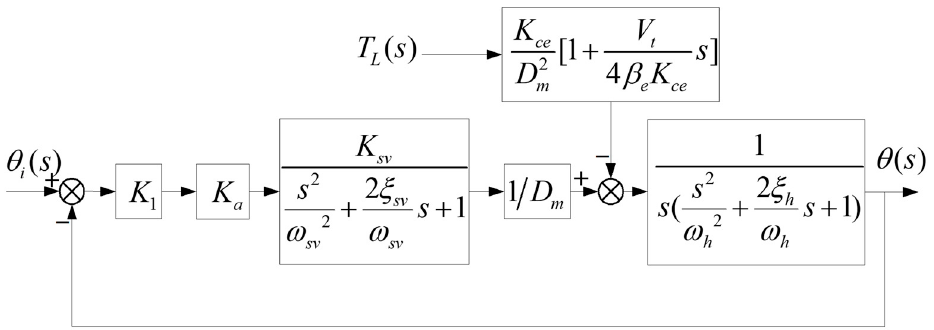
Figure 2. Block diagram of the transfer function of continuous rotary motor system. In the diagram, motor angle of the system; 1